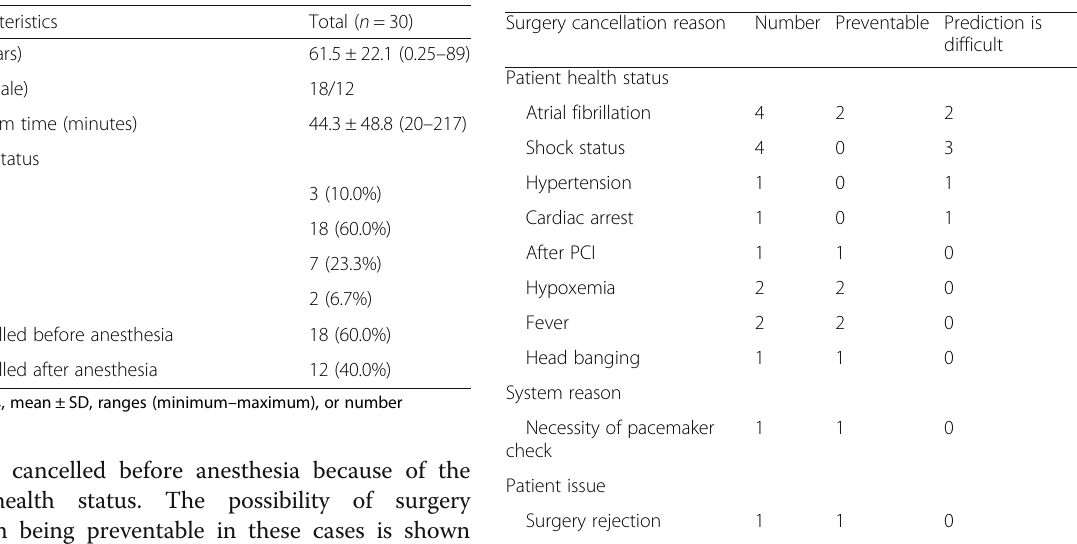
Table 1 Details of the patients ’ characteristics of those who had